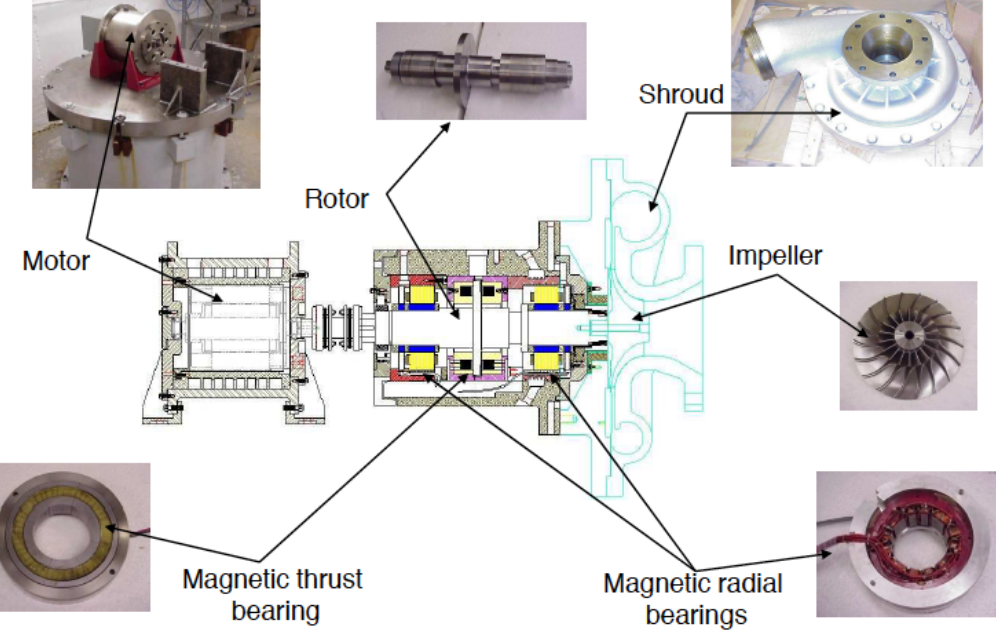
Figure 13. Components of the centrifugal